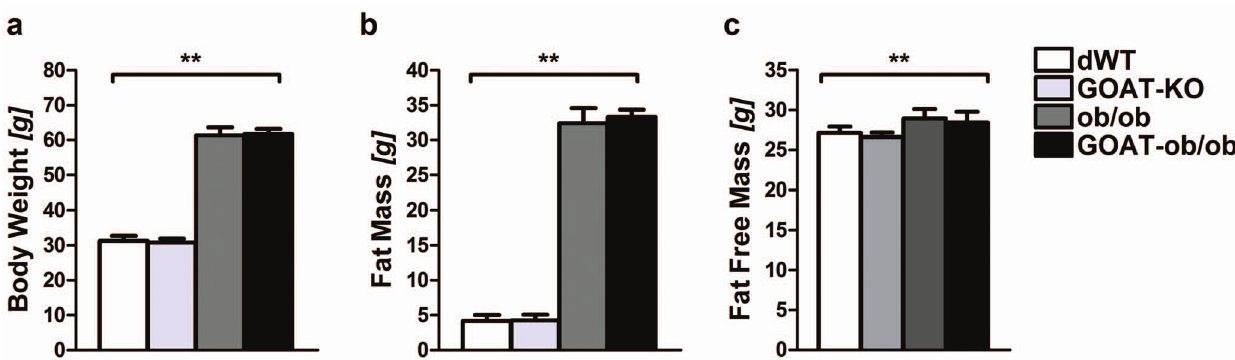
Figure 2. Body weight, fat mass and fat free mass in male mice lacking GOAT on a leptin-deficient ob/ob background. GOAT-ob/ob mice fed standard chow diet display no differences in body weight (a), fat mass (b), or fat free mass (c), compared to ob/ob littermates. However, both leptin-deficient mutants differ significantly in their body adiposity from GOAT-KO and dWT mice, respectively. ** P , 0.01 (1-way ANOVA); (n=5– 7).